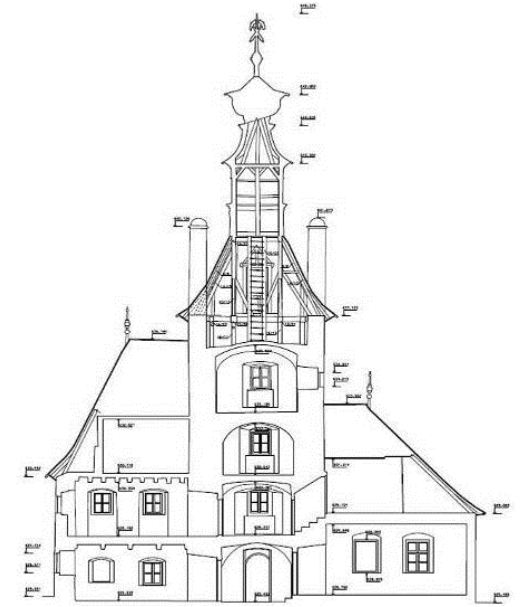
Figure 11. Longitudinal section view of the